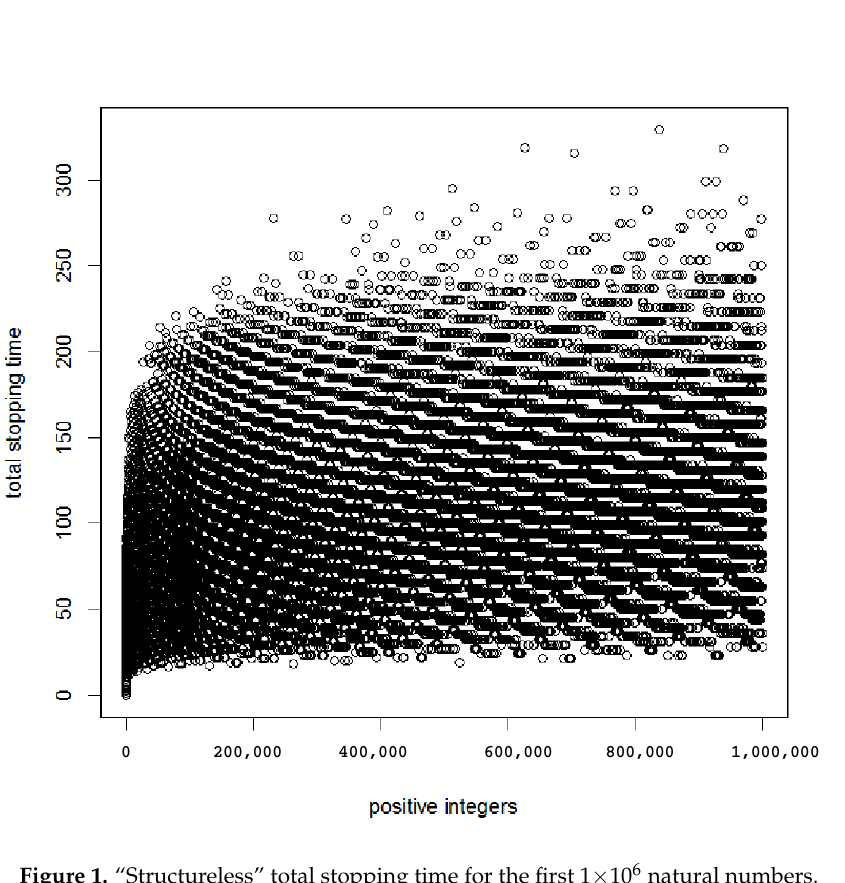
Figure 1. “Structureless” total stopping time for the first 1 × 10 6 natural numbers.